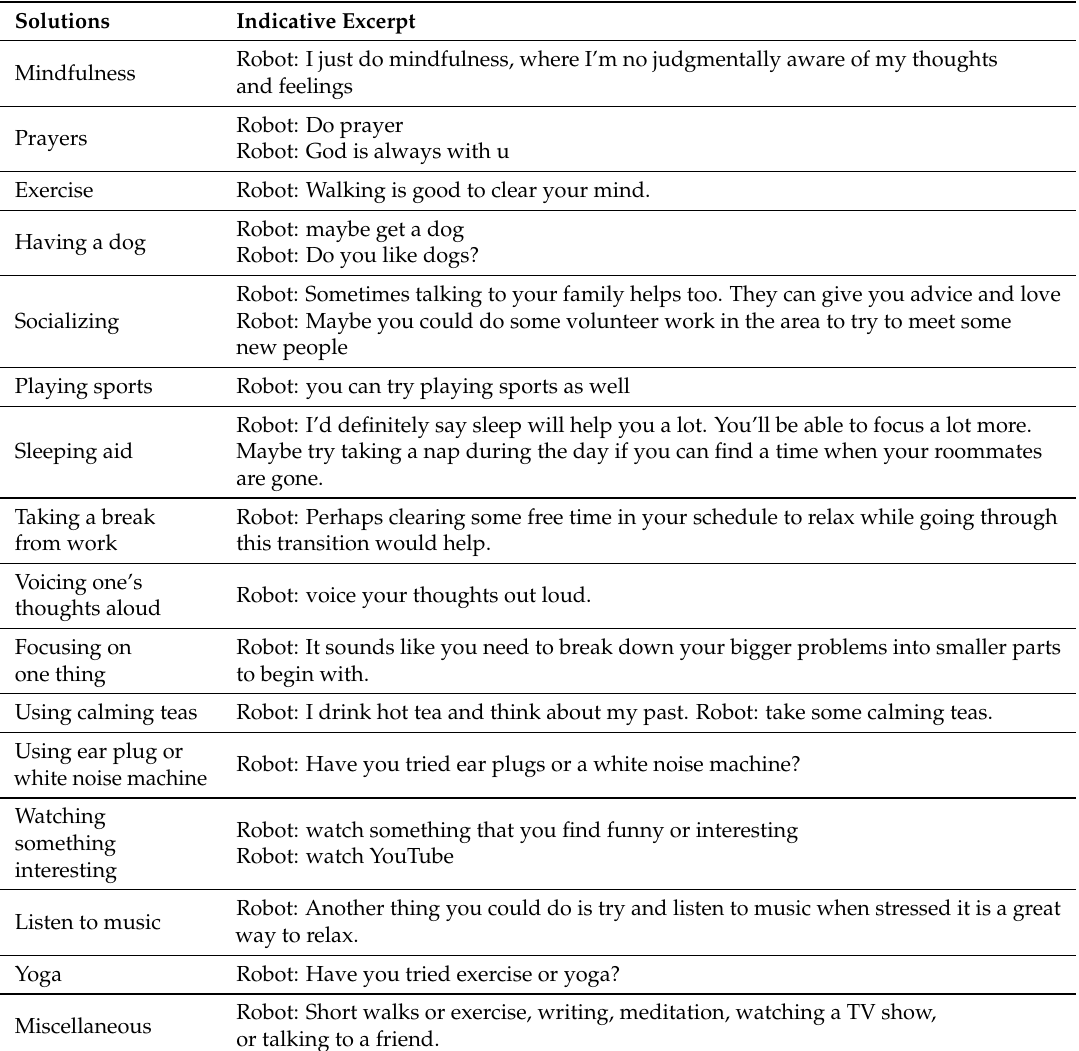
Table 4. Different solutions provided by crowd workers to allivate the stressful thoughts of an actress. Solutions Indicative